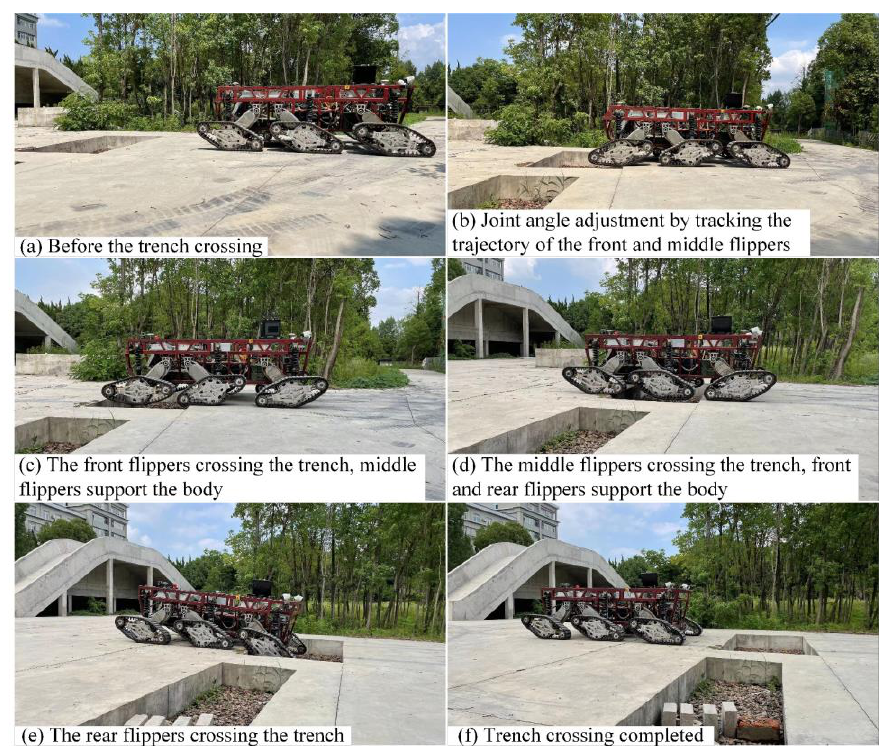
Figure 12. Snapshot of the autonomous controller traversing the trench terrain.